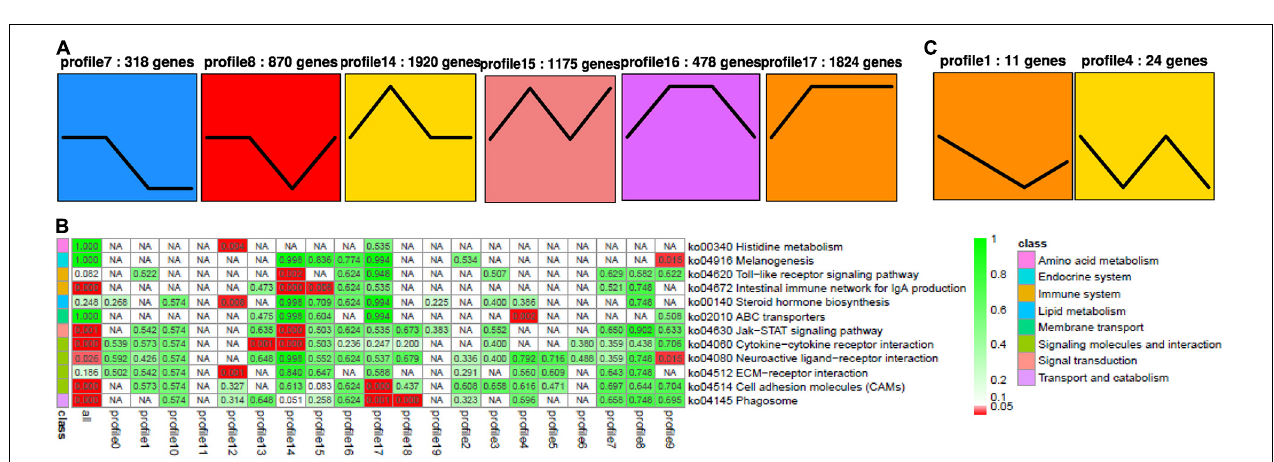
FIGURE 3 | Enriched KEGG pathway annotation of RNA (A) and top 20 KEGG pathways of RNA (B) and miRNA (C) . Statistical summary of distribution of genes in each pathway in each trend. Rich factor refers to the ratio of the number of genes in the pathway entry in the DEGs to the total number of genes in the pathway entry in all genes. The larger the rich factor is, the higher the degree of enrichment is. Q-value is the p -value corrected by multiple hypothesis test, and the value range is 0–1. The closer to zero, the more significant the enrichment is. The graph is drawn with the top 20 pathways sorted by Q-value from small to large.